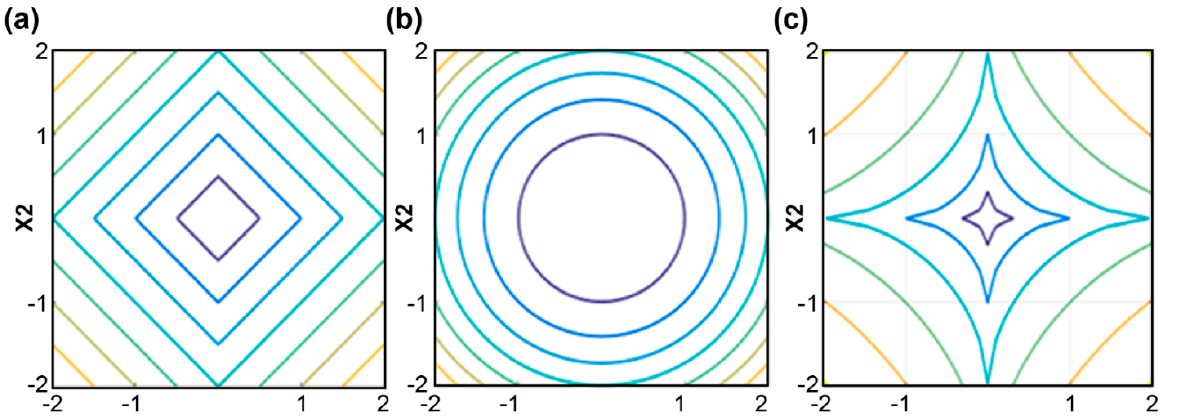
Figure 1. Contour maps of the different norms. ( a ) the L1 norm, ( b ) the L2 norm, and ( c ) the Lp-pseudo-norm.